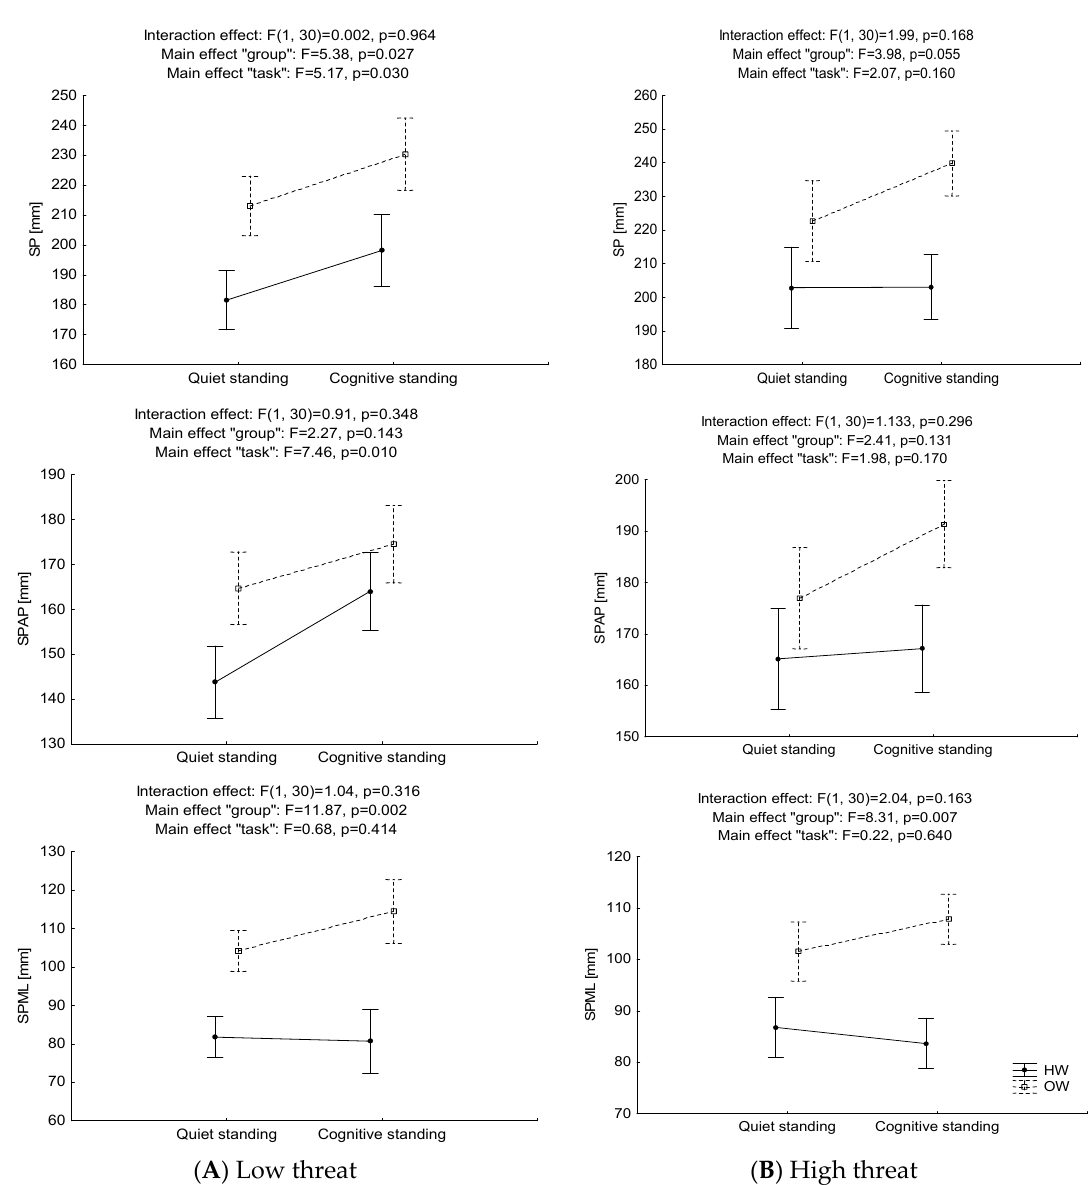
Figure 4. Mean values and standard error of measurements for sway path of COP displacement (SP) and its components in AP and ML directions for ‘‘task’’ factor (quiet standing and cognitive standing) and ‘‘group’’ factor (at-height workers—HW and office workers—OW) for low threat ( A ) and high threat ( B ).